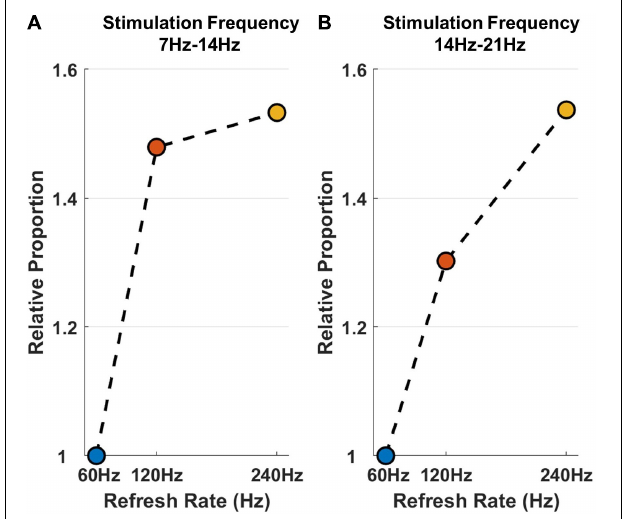
FIGURE 9 | The relative proportion of the response intensity difference between different motion forms. (A) The difference at the frequency of 7–14 Hz. (B) The difference at the frequency of 14–21 Hz. The horizontal axis and different colors indicate stimulation frequencies, and the vertical axis indicates the relative proportion of the response intensity difference between different motion